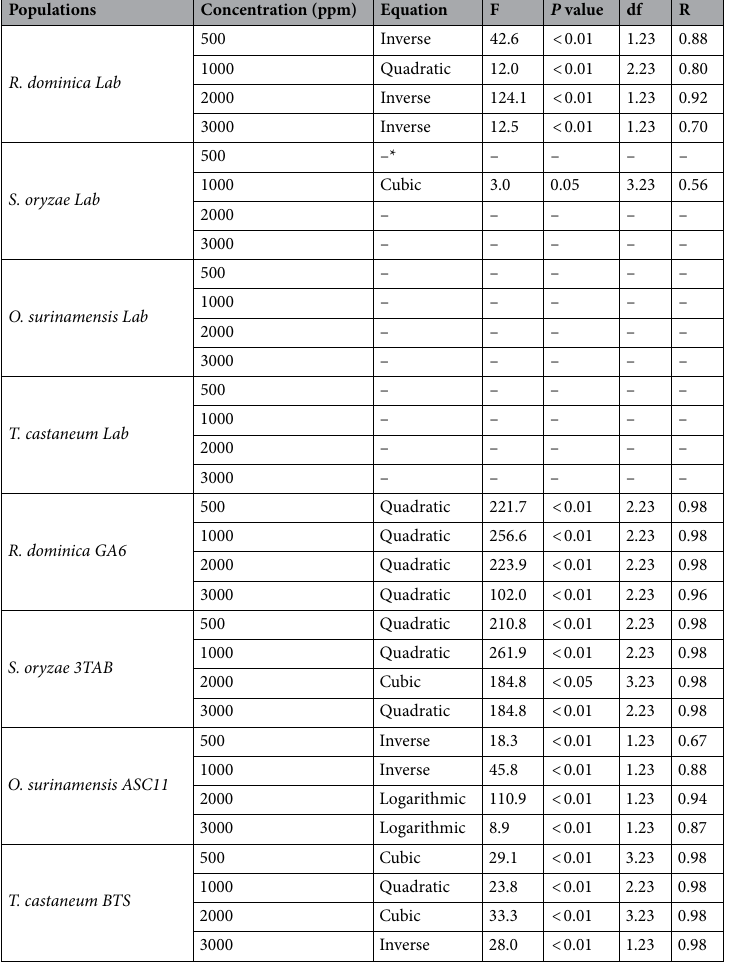
Table 5. Sweet spot curve estimations for immediate effects, of insects exposed on different concentrations (500, 1000, 2000 and 3000 ppm) for all exposure intervals (1, 3, 5, 20, 30 and 40 h), for each species and population. *Equations could not be